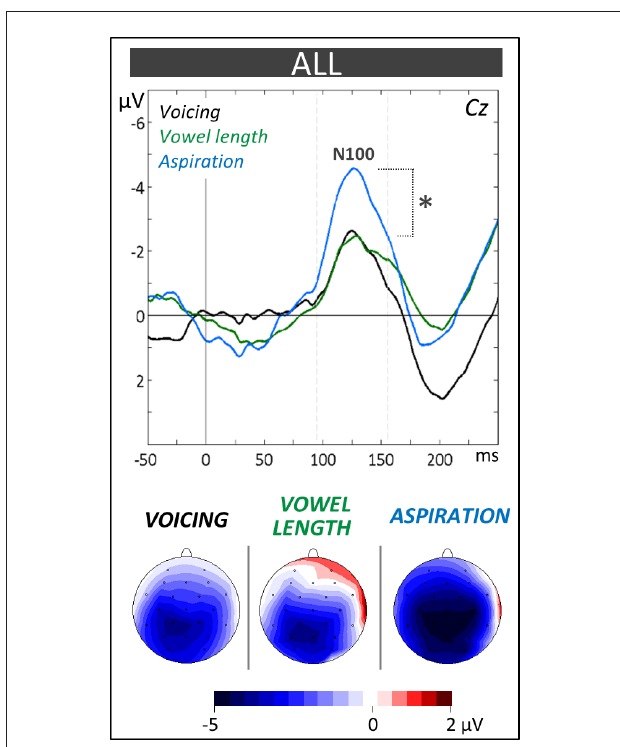
FIGURE 3 | Phonological categorization tasks . N100 components at the Central (Cz) electrode and topographic voltage distribution maps are compared between tasks averaged across children (ALL). Voltage values of topographic maps are scaled from –5 µ V to +2 µ V. Mean number of trials contributing to the averages ( n = 1228). In this and subsequent ERPs figures, time in milliseconds is in abscissa and the amplitude of the effects in microvolt is in ordinate. Time zero corresponds to word onset and negativity is plotted upwards. Latency windows for statistical analyses are indicated with gray dotted lines and the level of significance is indicated by stars with ∗ p < 0.05, ∗∗ p < 0.01 and ∗∗∗ p <